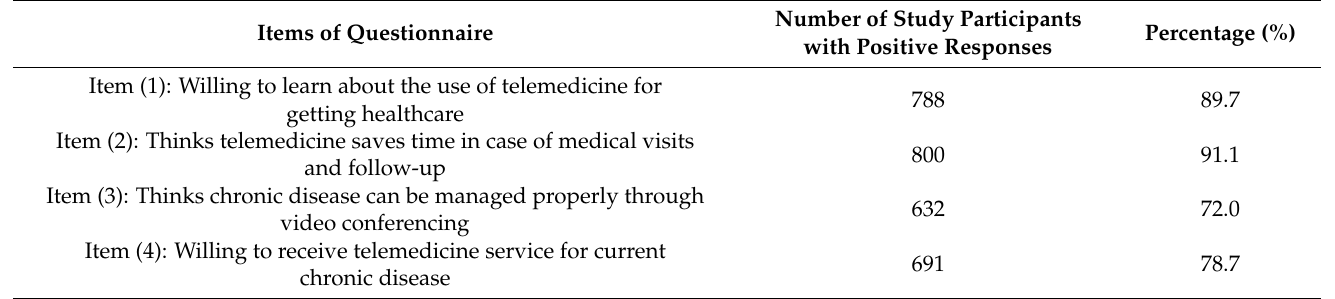
Table 3. Participants’ replies to the nine-item questionnaire (%) (N =